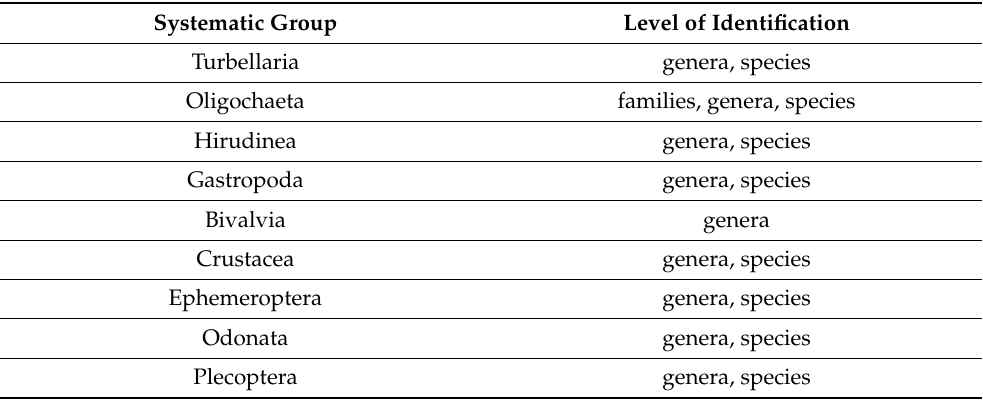
Table 1. Level of identification of the systematic groups established during the study.